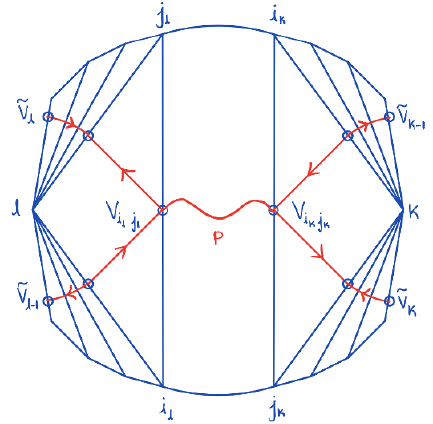
Figure 4 . Arbitrary triangulation of an